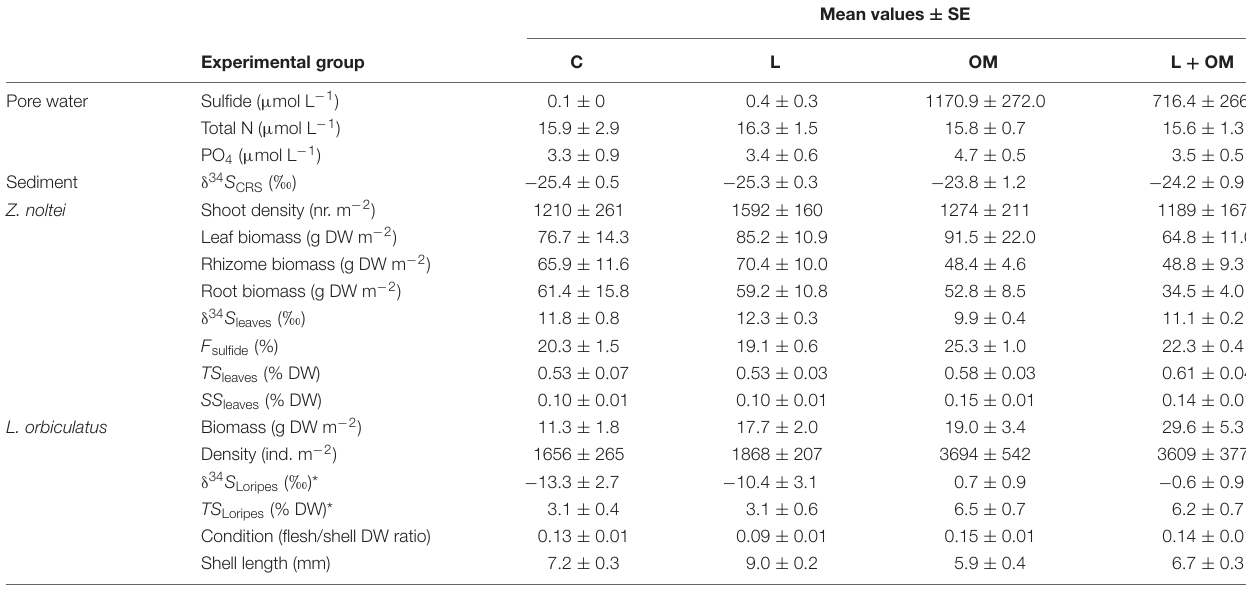
TABLE 1 | Mean values ± SE for all response variables per experimental